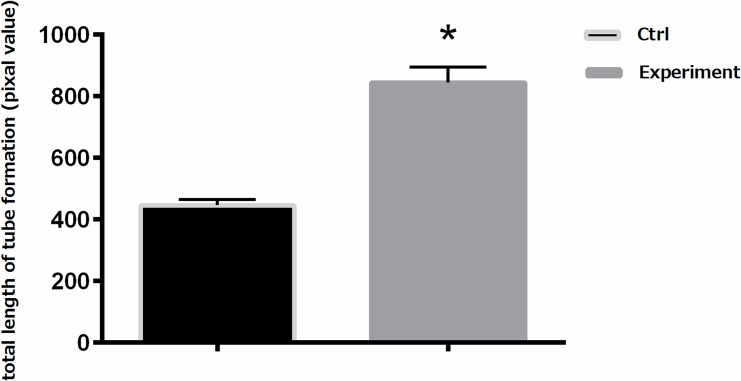
The total length of tube formation of HUVECs.The total length of tube formation in both the experimental groups and control groups were analyzed by Image-Pro Plus 6.0 software. The figure shows that the total length of tube formation in the experimental groups was higher than the control groups (P<0.05).